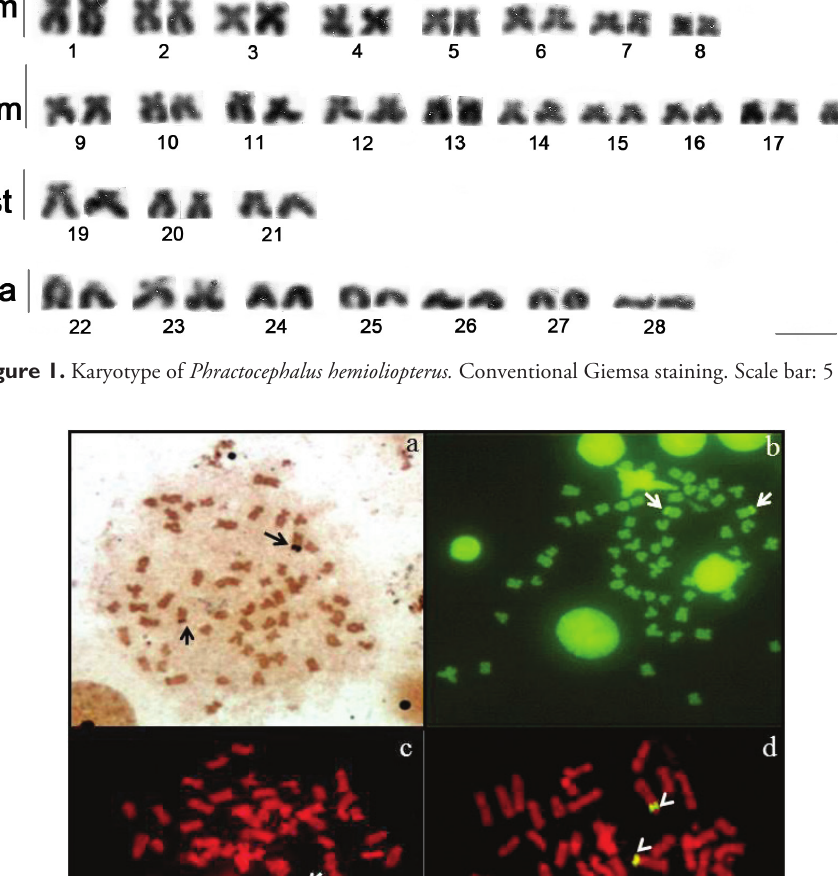
staining b CMA banding c FISH 3 3